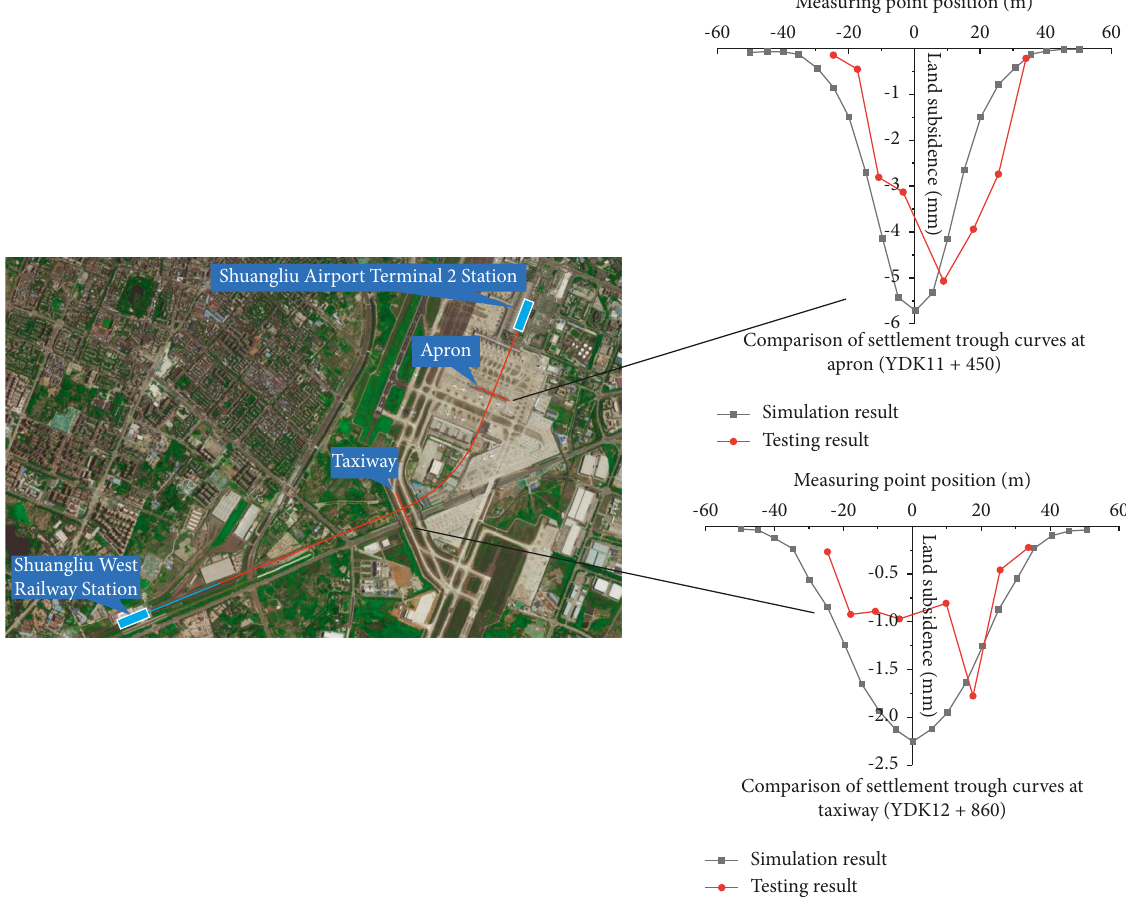
Figure 8: Comparison between plane diagram of section tunnel and settlement trough